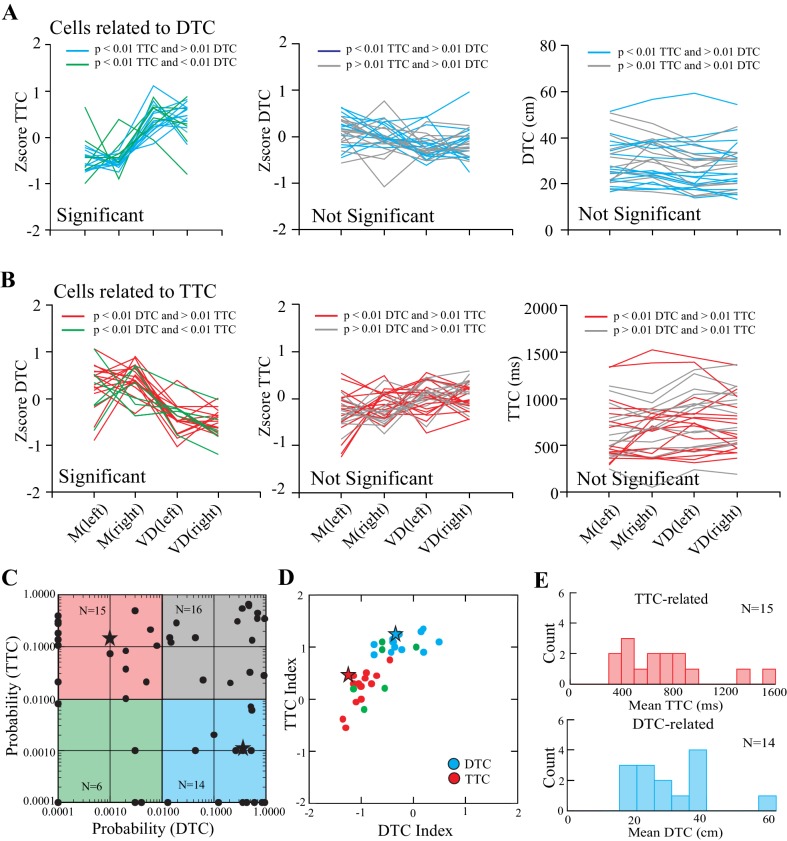
Relationship of cell discharge onset to distance and time (population analysis).(A) Cells showing both a significant effect of TTC (left, cyan lines) and a non-significant effect of DTC (middle and right, cyan lines). (B) Cells showing a significant effect of DTC (left, red lines) and a non-significant effect of TTC (middle and right, red lines). Green lines in A, B (left) indicate cells showing a significant relationship to both DTC and TTC. Gray lines (middle and right) indicate cells showing a non-significant relationship with each. Magnitude of the response is plotted as a Z score in the left and middle plots and as absolute values on the right. (C) Probability of a significant relationship with TTC as a function of the probability of a significant relationship to DTC (log scales). Cyan rectangle illustrates the 14 DTC-related cells and the red rectangle illustrates the 15 TTC-related cells. Cells that had no relationship to either are clustered in the top right, whereas those with a significant relationship to both are in the bottom left. (D) Modulation index (see Materials and methods) for the DTC and TTC cells; green symbols indicate cells with a significant relationship to both. Asterisks in C and D indicate the two cells illustrated in Figure 4. (E) Histograms illustrating the distribution of values for TTC- and DTC-related cells. (Figure 5—source data 1 and 2). Figure 5—figure supplement 1: Bootstrapped data for index of TTC- and DTC-related cells.10.7554/eLife.28143.017Figure 5—source data 1.Source data for graph in Figure 5D.10.7554/eLife.28143.018Figure 5—source data 2.Source data for graphs in Figure 5C,E.10.7554/eLife.28143.019Figure 5—source code 1.Script for data in Figure 5.